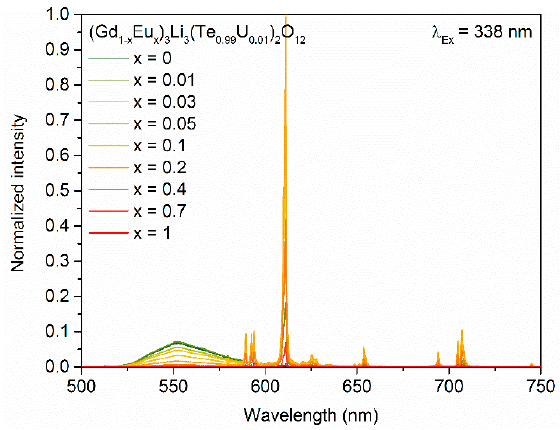
Figure 9. Emission spectra of (Gd 1 − x Eu x ) 3 Li 3 (Te 0.99 U 0.01 ) 2 O 12 with 0 ≤ x ≤ 1 under 338 nm excitation. Table 1. External quantum efficiencies, color coordinates, and luminous efficacy of (Gd 1 − x Eu x ) 3 Li 3 (Te 0.99 U 0.01 ) 2 O 12 with 0 ≤ x ≤ 1 upon 338 nm